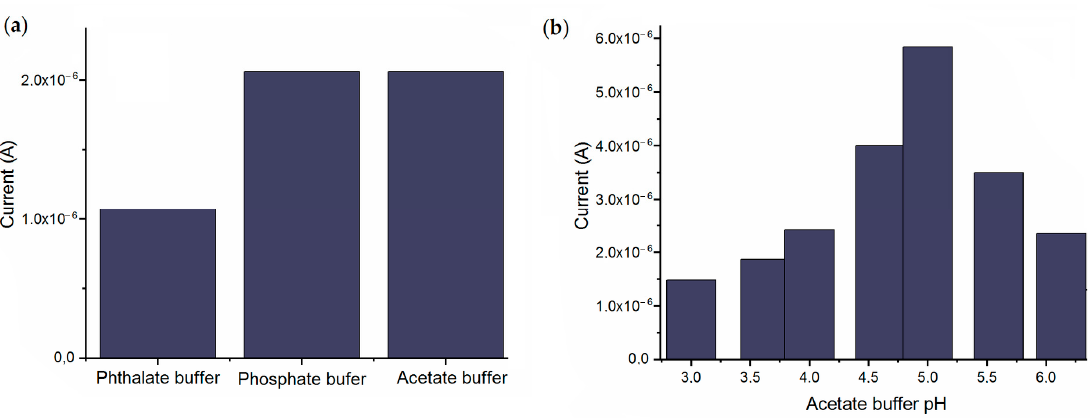
Figure 4. ( a ) Effect of type of buffer on current of GCE/laccase 30 and ( b ) effect of acetate buffer pH on current of GCE/laccase 30 .